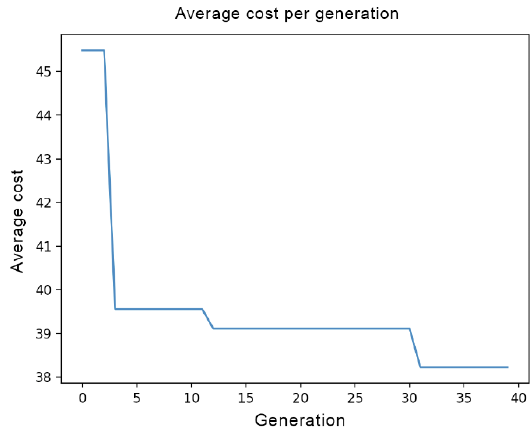
Figure 4. Reduction in cost during optimization for 40 generations.